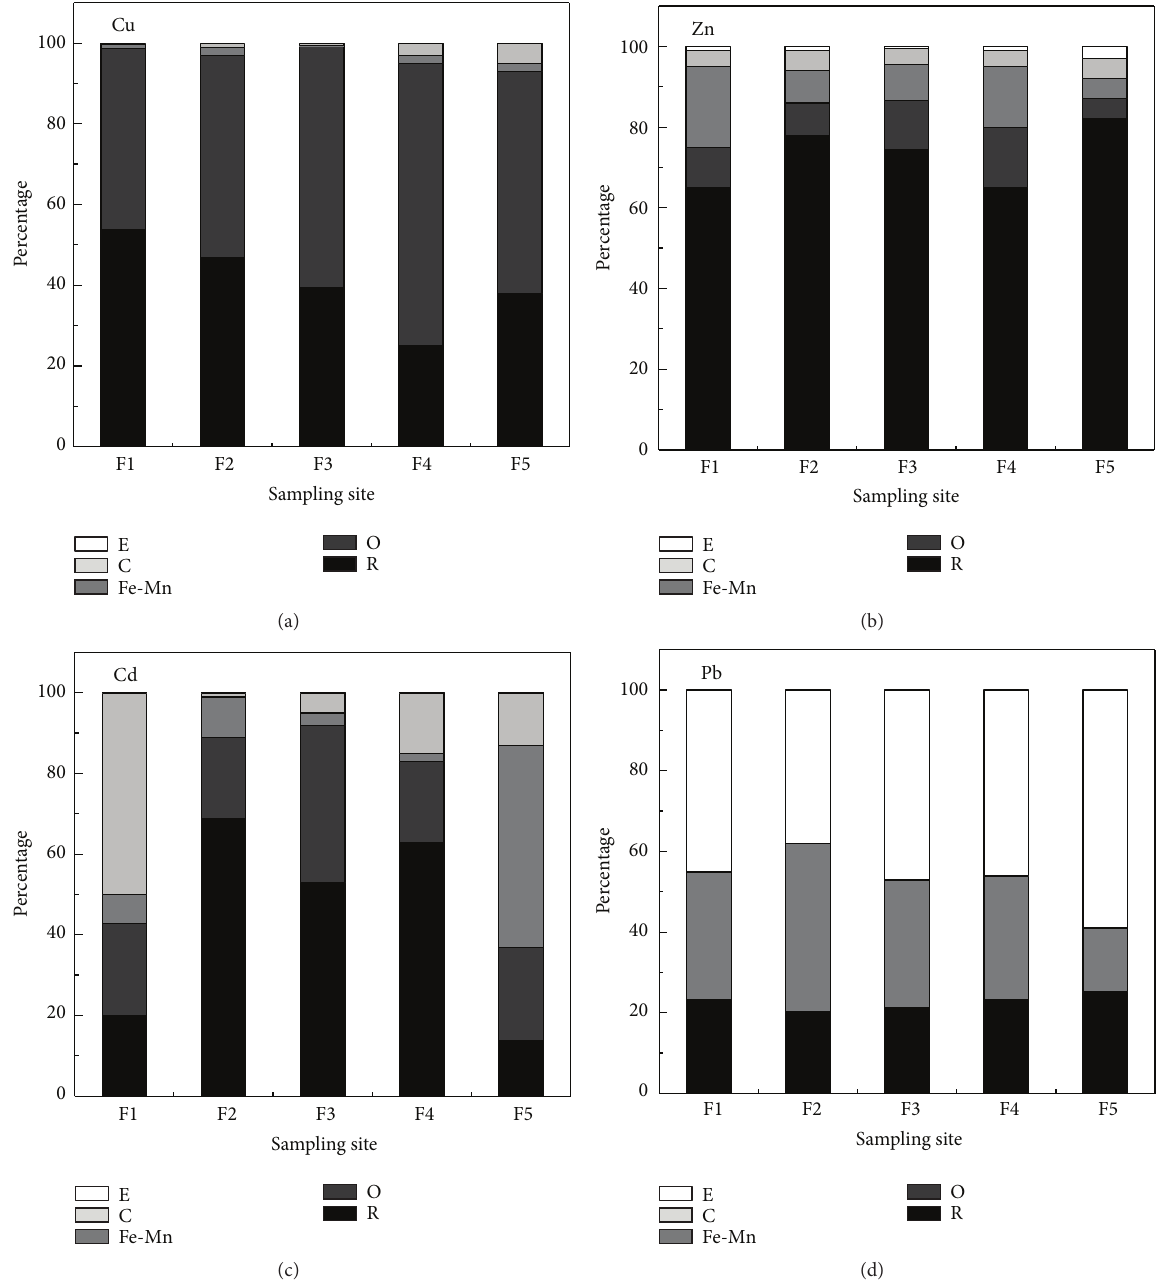
Figure 4: The fractionation distribution of metals Cu, Zn, Cd, and Pb at Fuwai Street. Note: E, C, Fe-Mn, O, and R represent exchangeable fraction, carbonate bound fraction, Fe-Mn oxide bound fraction, organically bound fraction, and residual fraction,